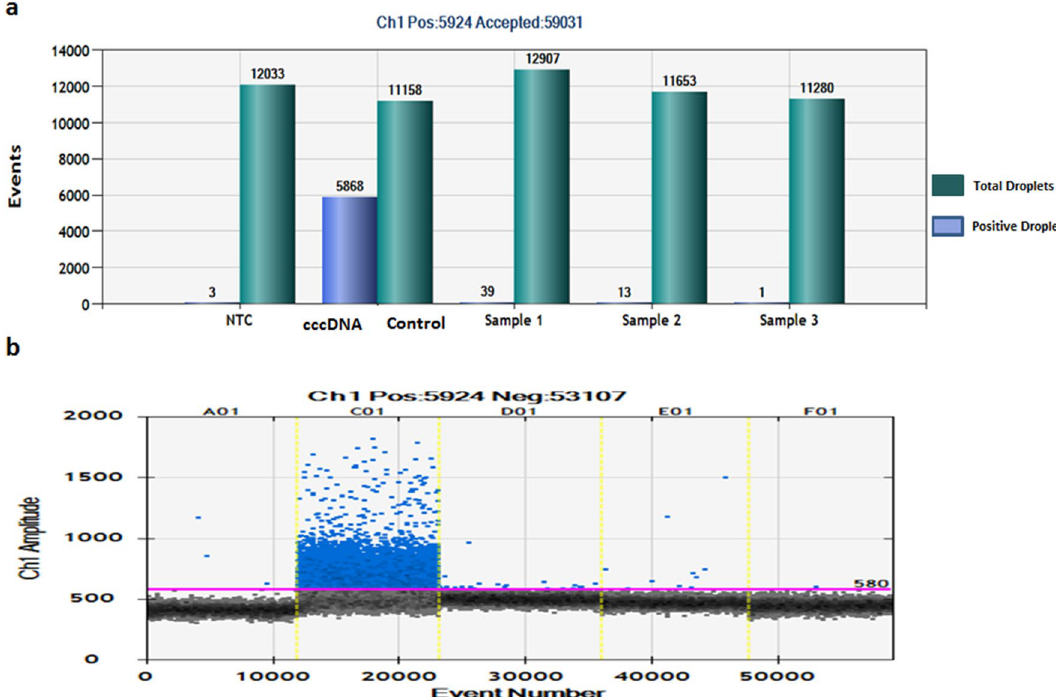
Figure 2. Presence of cccDNA in placenta. ( a ) cccDNA was detected through fluorescence amplitudes of HBV in the infected samples using Digital Droplet PCR (ddPCR), Absolute quantification of cccDNA showed more than 11,000 events generated in which, the highest positive droplets were found in positive control isolated from HepAD38 cells 11 , while in Sample 1 (S1), Sample 2 (S2), Sample 3 (S3) and NTC; 39, 13, 1 and 3 positive droplets were observed, respectively. We consider sample positive for cccDNA if more than 3 droplets are detected. ( b ) Plot showing threshold fluorescence amplitude and droplet